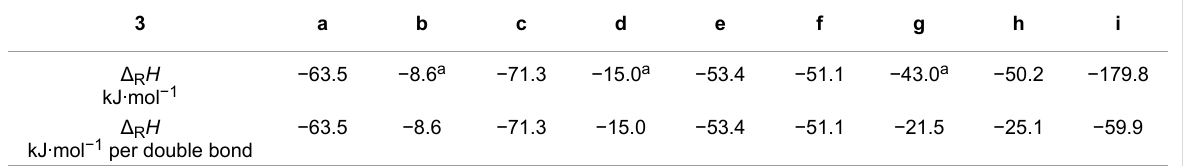
Table 2: Polymerization enthalpy of N -alkyl- N -(phosphonoethyl) substituted (meth)acrylamides 3 using a photo calorimeter DSC7/DPA7 (Perkin- Elmer); light intensity in the visible portion of the spectrum was 108 mW cm −2